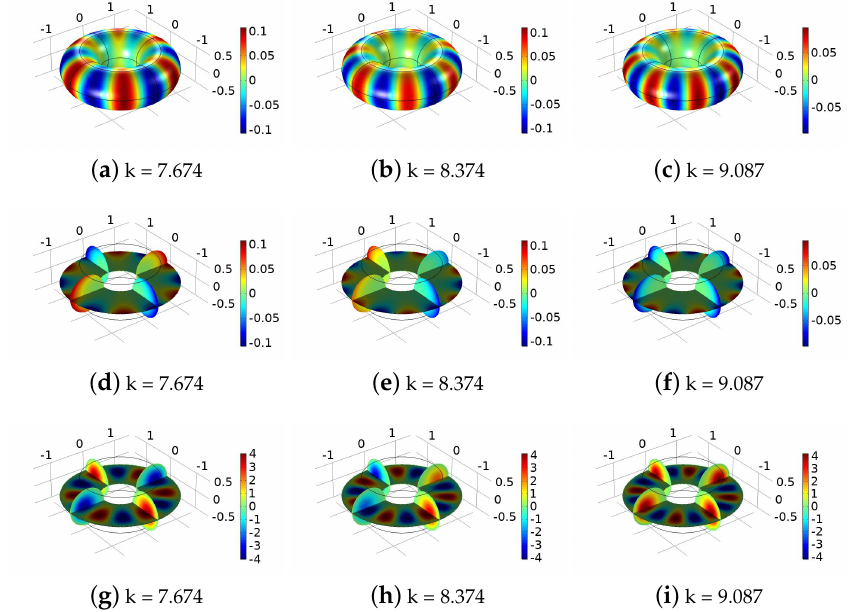
Figure 12. The magnitude of transmission eigenfunctions for a torus with different k ’s. ( a – c ): surface of w ’s and v ’s; ( d – f ): eigenfunctions w ’s; and ( g – i ): eigenfunctions v ’s. Table 1. Summary of numerical results.